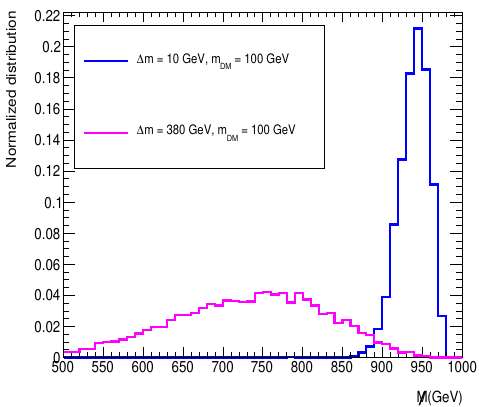
Figure 25. Normalised /M distribution for two cases with same DM mass and different ∆ m (see figure insets for details). The production and decay chain remains similar to that of figure